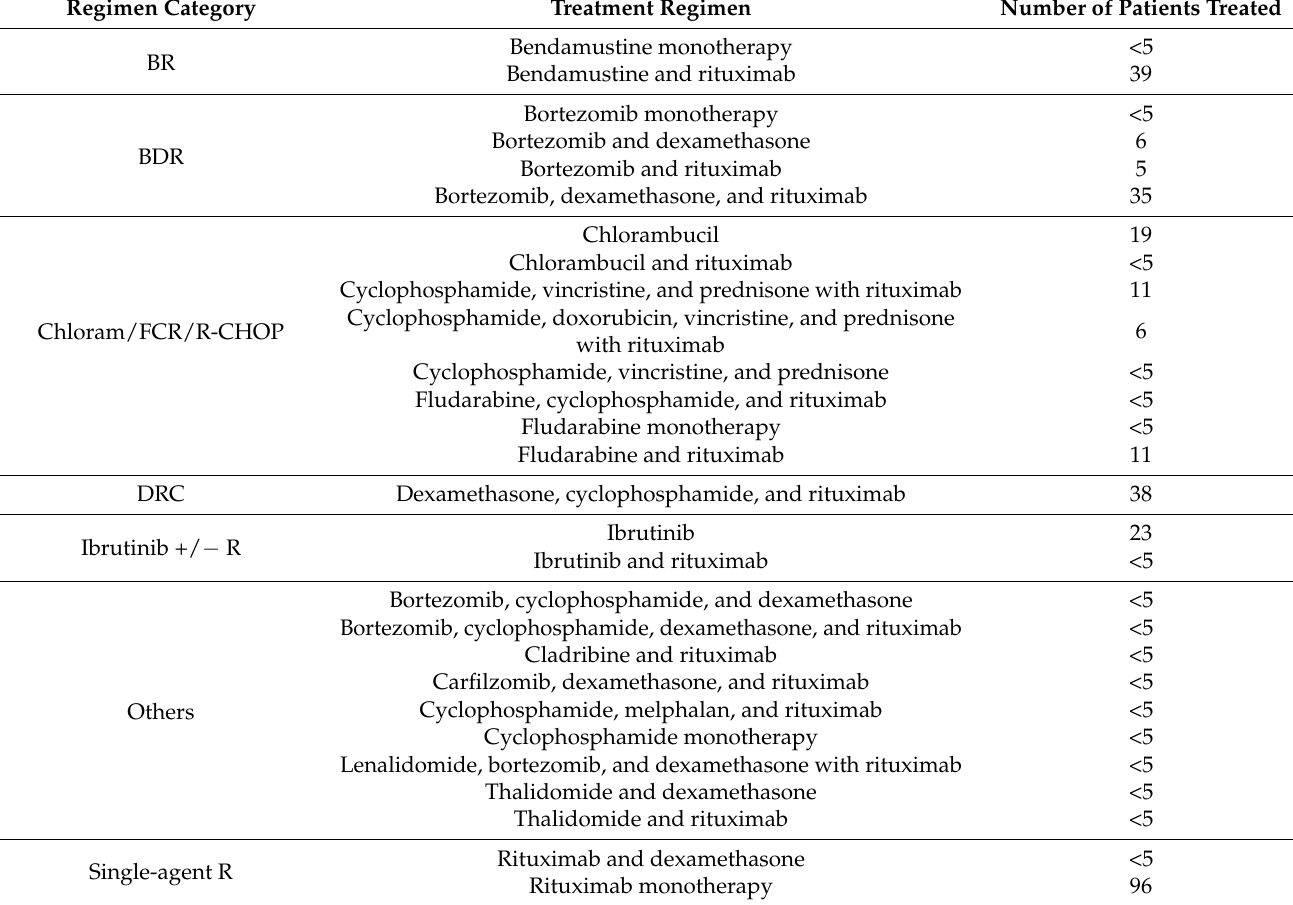
Table 2. Treatment regimens received by Veterans with Waldenström macroglobulinemia, 2006 to 2019. Regimen